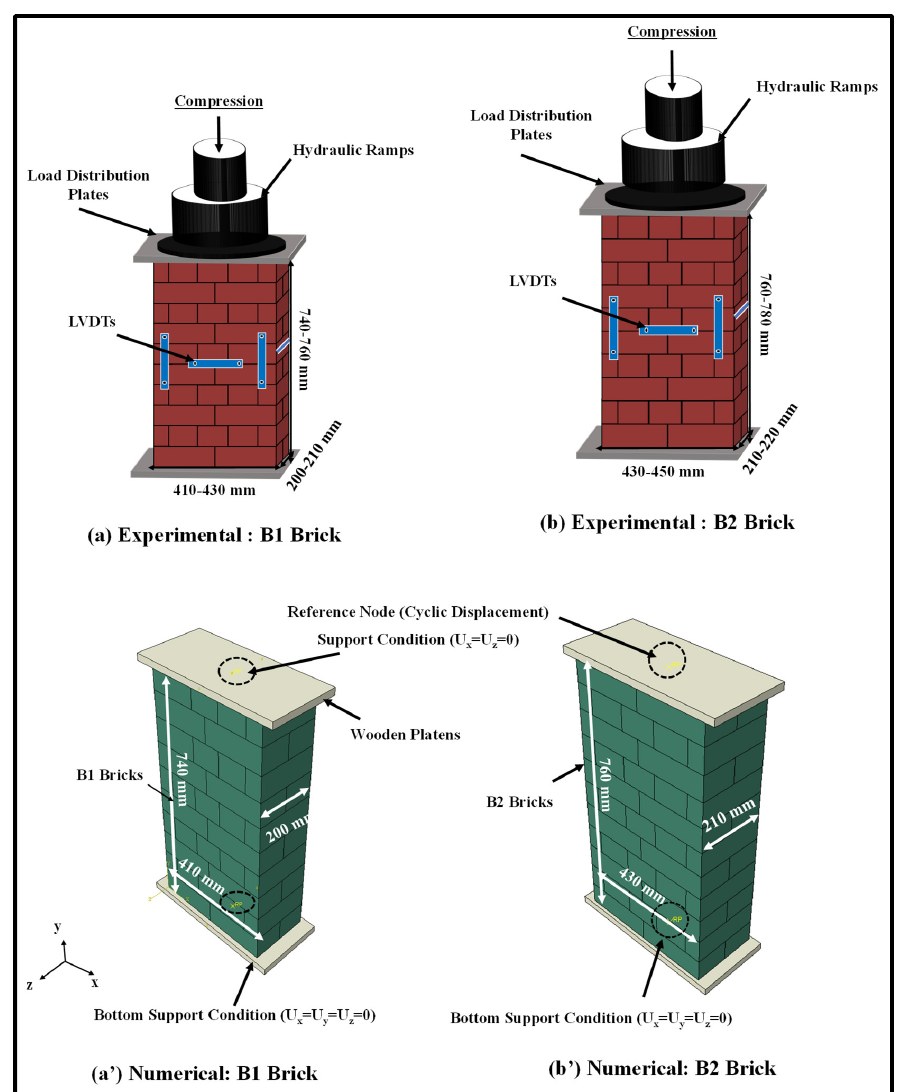
Figure 2. Geometrical representation of masonry wallettes during experimental setup and corresponding numerical representation; ( a ) B1 and ( b ) B2 wallettes.